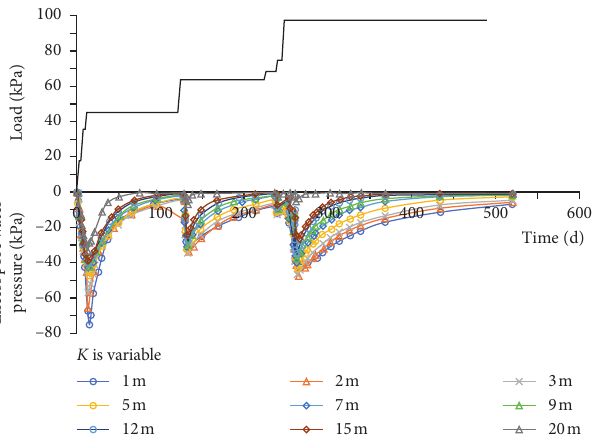
Figure 13: Variation curve of the excess pore water pressure of the soil layer under the drainage